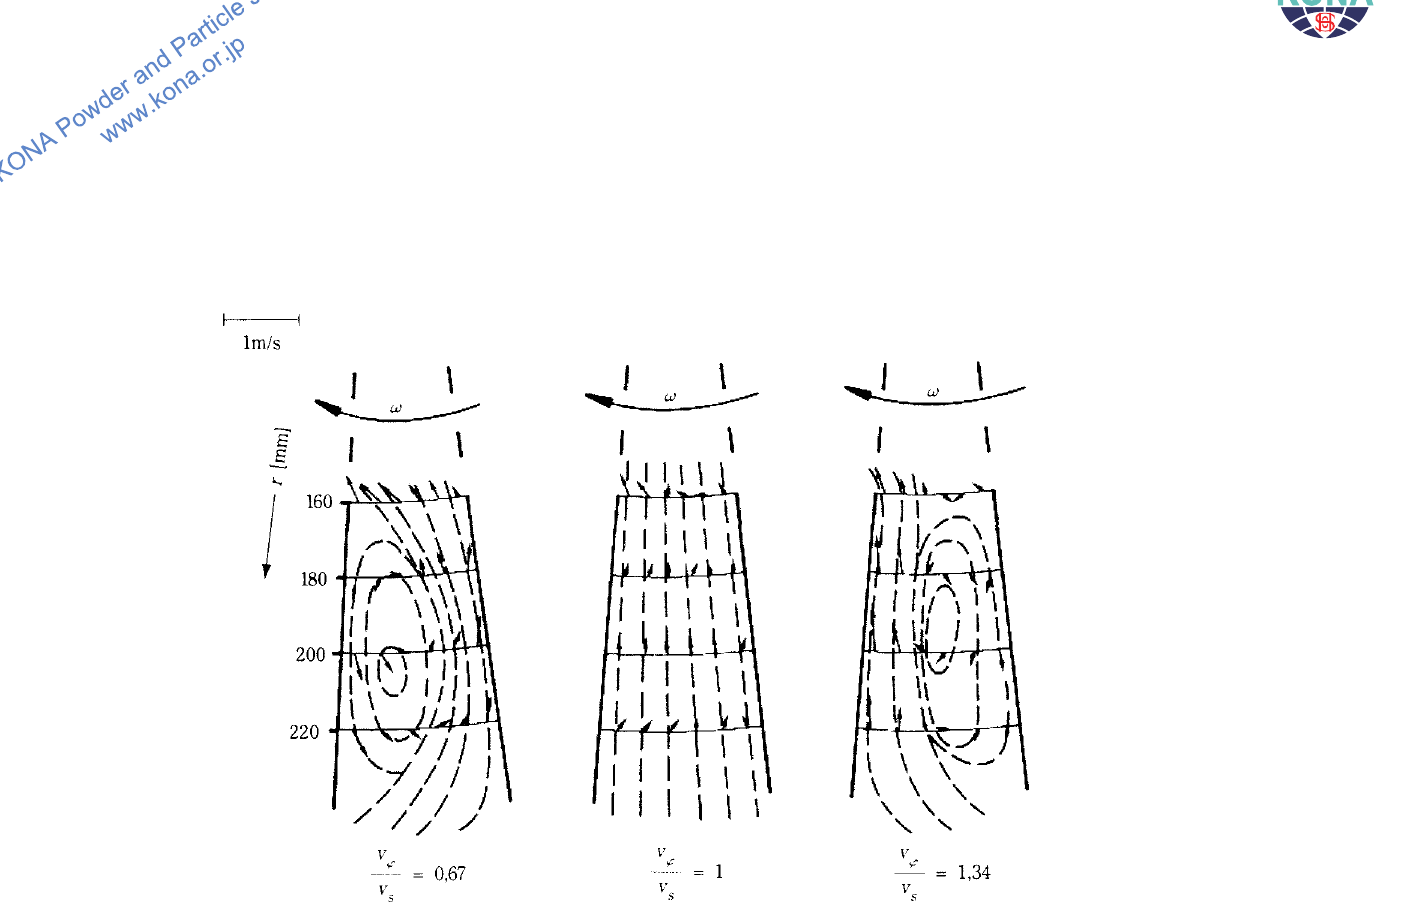
Fig. 6 Flow patterns with different v_,/"-•r-ratios